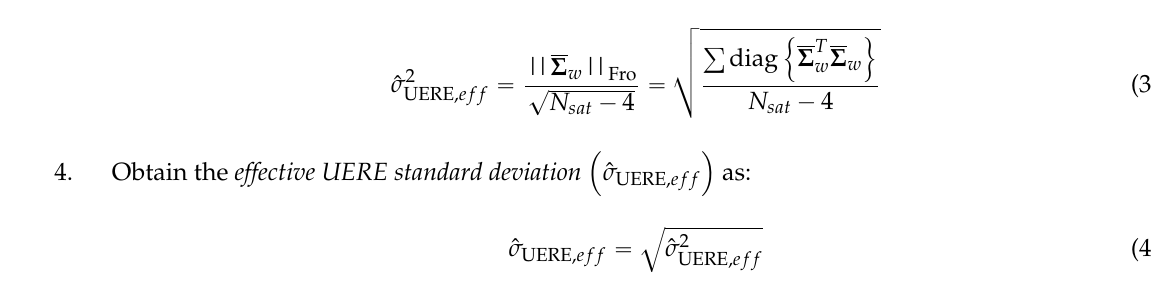
parameter represents a statistical characterization of the “local”